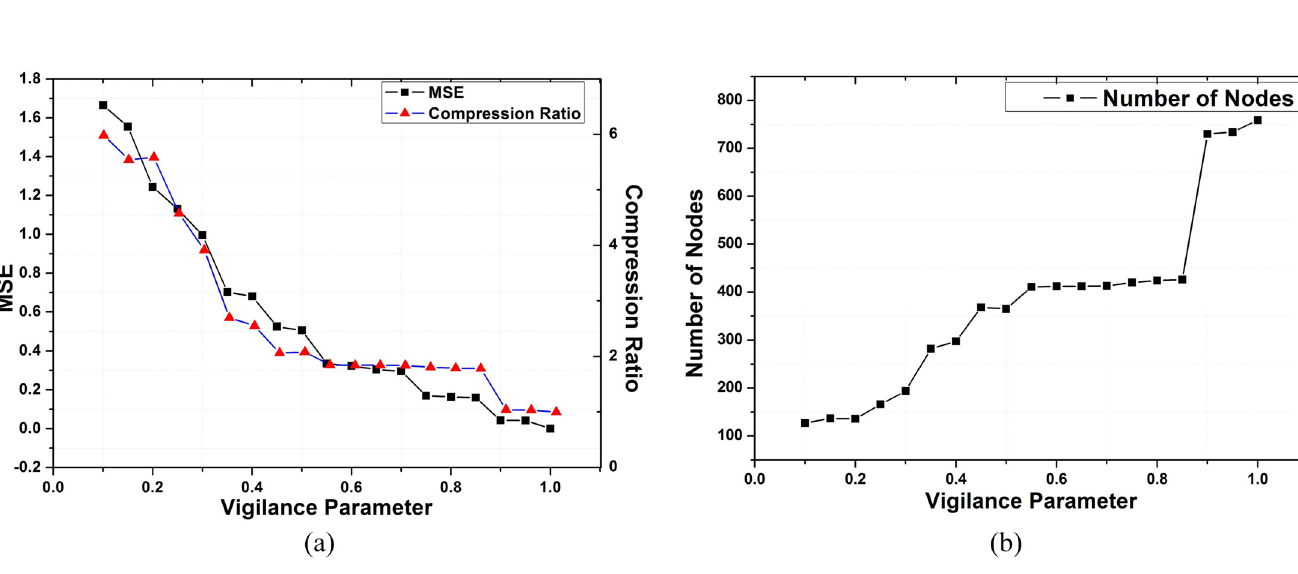
PLOS ONE | DOI:10.1371/journal.pone.0152003 March 21,